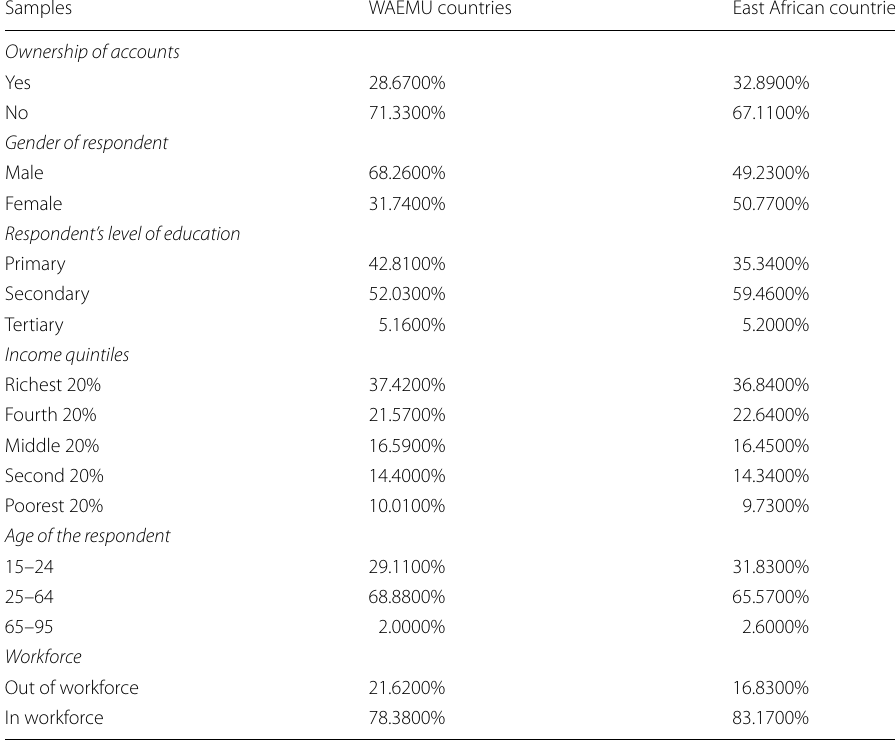
Table 6 Mobile money account penetration rates by individual characteristics. Source : Author’s calculations